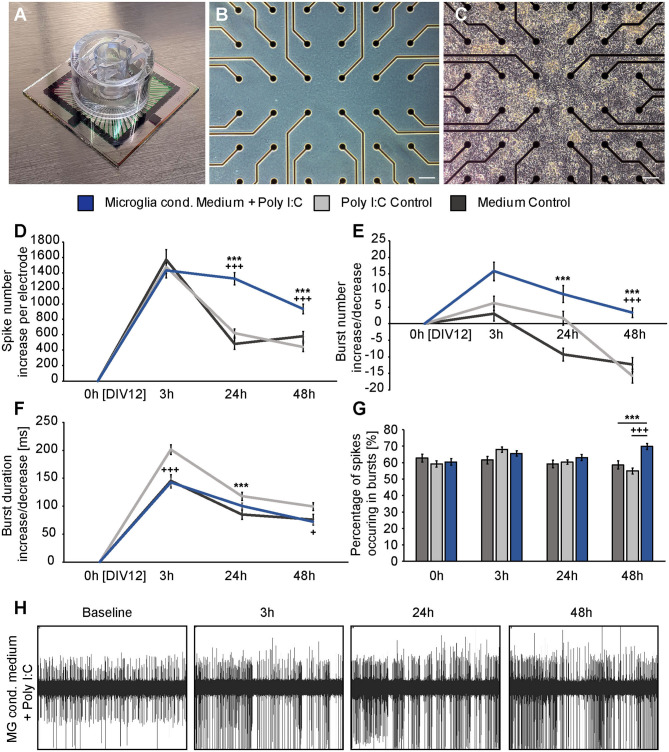
(A) Standard 60MEA200/30iR-Ti-gr with a custom manufactured transwell holder on top; (B) Phase contrast image of an empty electrode field without neurons; (C) Phase contrast image of a dense neuronal network cultured on the electrode field of a MEA; (D) The absolute increase of single occurring action potentials, so-called spikes was analyzed 3, 24, and 48 h after administration of previously conditioned medium of Poly I:C activated microglia (blue), sole fresh medium (dark gray) or Poly I:C containing medium (light gray). A significant increase in the number of spikes could be detected after 24 h and 48 h when neurons were treated with microglia conditioned medium (* represents significant to medium control, + represents significant to Poly I:C control). In contrast, both control conditions nearly reached the baseline level after 24 and 48 h; (E) The increase of organized network firings, so-called bursts, after the medium exchange was determined. As previously, the strongest increase was observed in the condition with microglia conditioned medium; (F) Burst duration analysis did not reveal significant changes between neuronal cultures treated with microglia conditioned medium and culture medium. However, Poly I:C containing medium increased the burst duration significantly after 3 h compared to neurons treated with microglia conditioned medium and after 24 h compared to the medium control; (G) The percentage of spikes in bursts was just increased after 48 h in the microglia conditioned medium group; (H) Representative MEA recording of one electrode after treatment with microglia conditioned medium. The increasing number of recorded spikes can clearly be seen. Statistics: Five independent experiments (N = 5) were performed for the medium control and Poly I:C control. Four independently prepared cultures (N = 4) were treated with microglia conditioned medium. In total, data of 240–300 electrodes were considered for quantification. Data are shown as mean ± SEM (Kruskal-Wallis test with Dunn's multiple comparison, *p ≤ 0.05, **p ≤ 0.01 and ***p ≤ 0.001; +p ≤ 0.05, ++p ≤ 0.01 and +++p ≤ 0.001). Here, the Kruskal-Wallis test was separately performed for each recording time point. A comparison of the mean values between time points was not included. Scale bar: 100 μm.